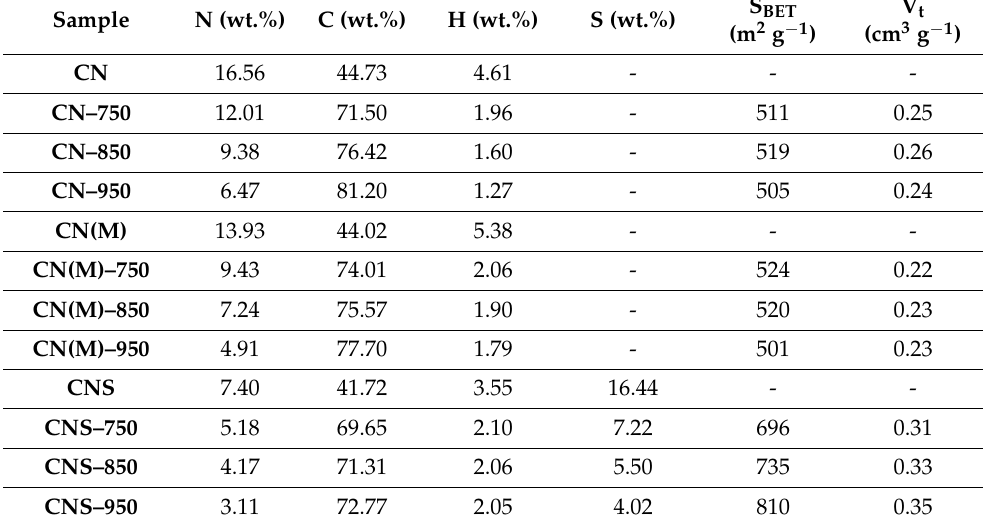
Figure 6. The spectra of nitrogen and sulfur elements in the organic polymers are quite simple, because they correspond to the thiazole heterocyclic ring (aromatic,